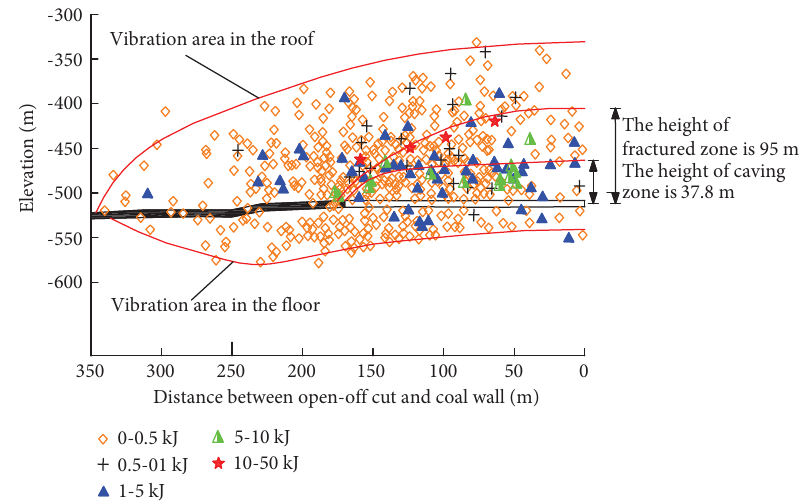
Figure 7: Height of the caving zone and fracture zone revealed by microseismic